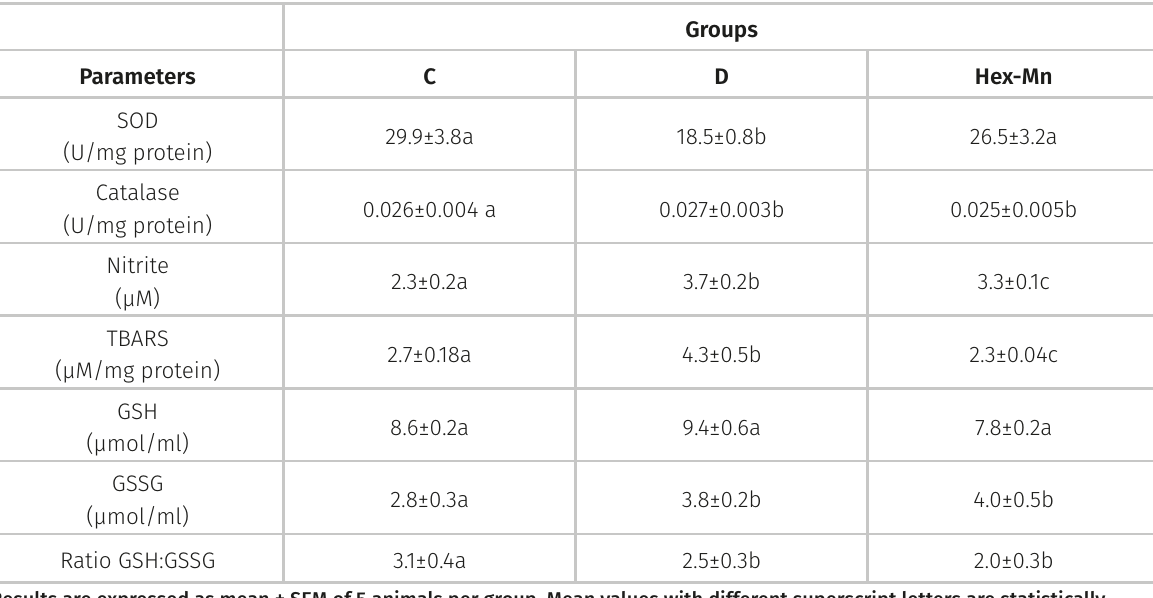
Figure 2. Effect of Hex-Mn fraction on carbohydrate oral tolerance test in control and STZ diabetic rats treated for 21 days. (a, c, e) Glycemia levels before (t = 0) and after glucose load in rats treated for 21 days; (b; d, f) area under the curve (AUC) of the oral carbohydrate tolerance test. Results are expressed as mean ± S.E.M. of 7 animals per group. Mean values with different superscript letters are statistically different at p< 0.05 and were analyzed using